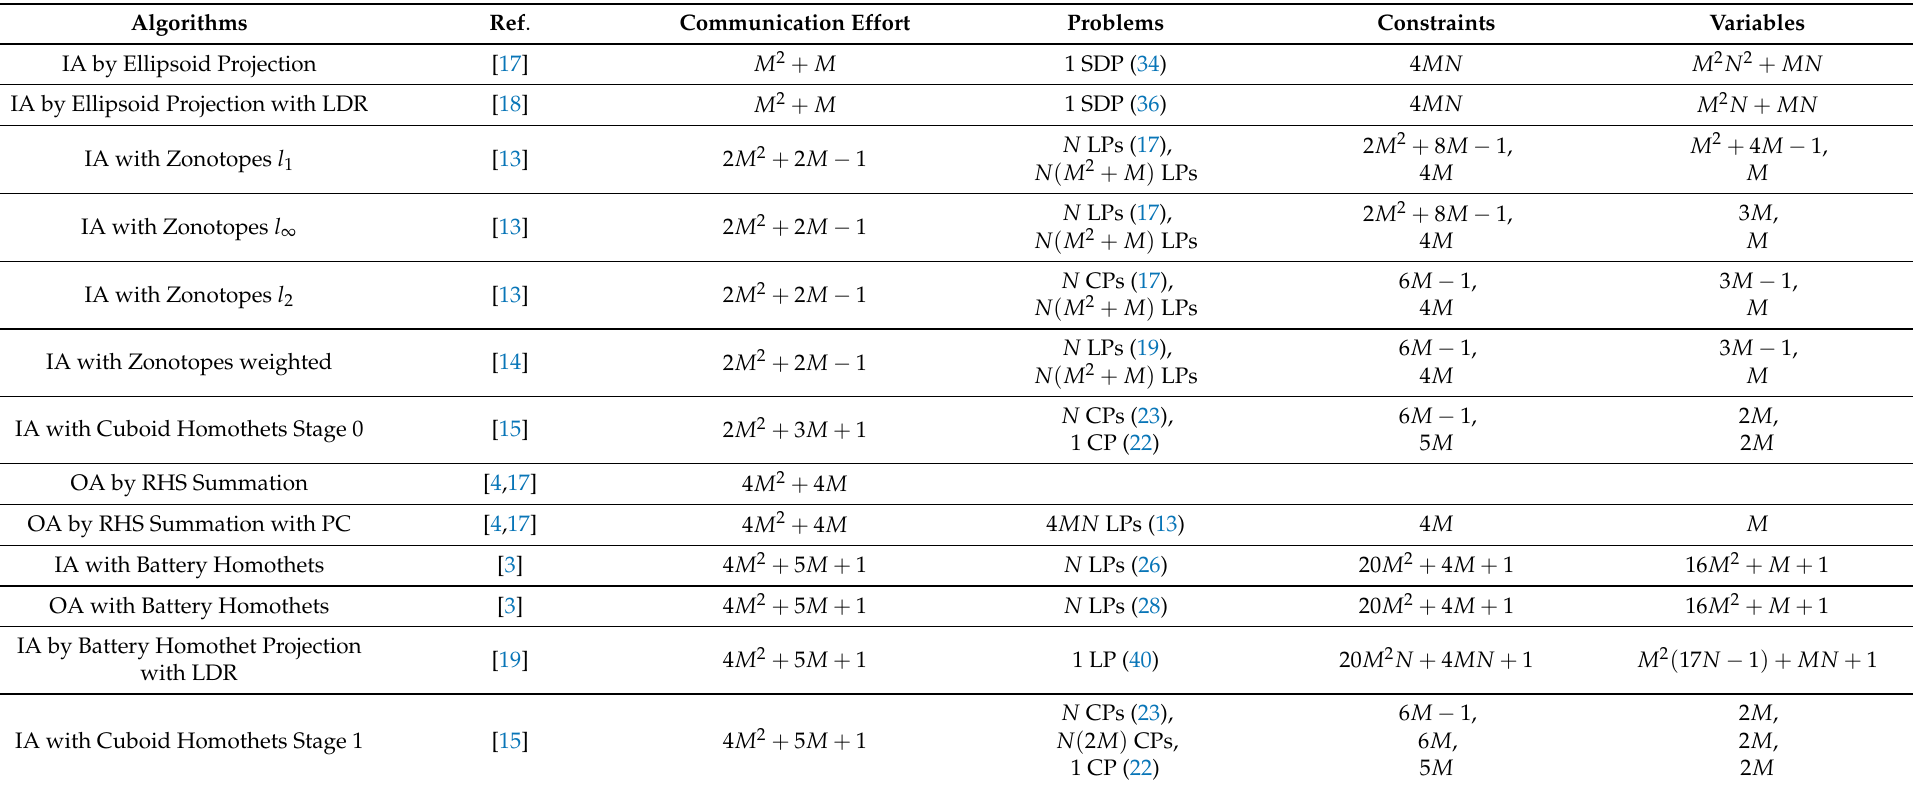
Table 1. Communication effort given by floating point numbers that have to be sent to the utility, and computation effort in dependence of the number of households N and number of time periods M